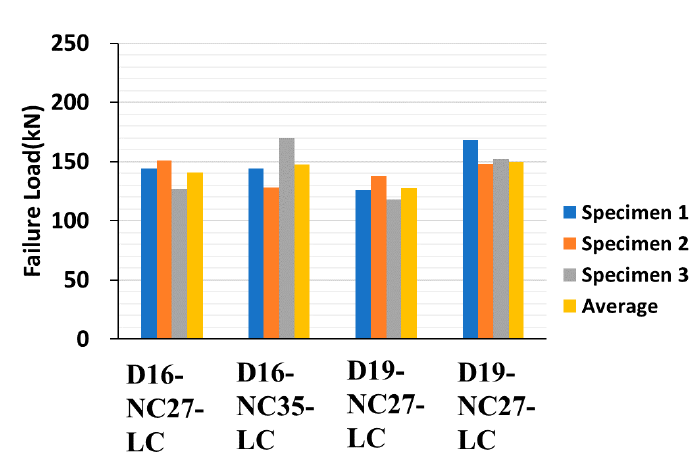
Figure 15. Pull-out test results of 16 and 19 mm GFRP rebars (27 MPa, 35 MPa,).